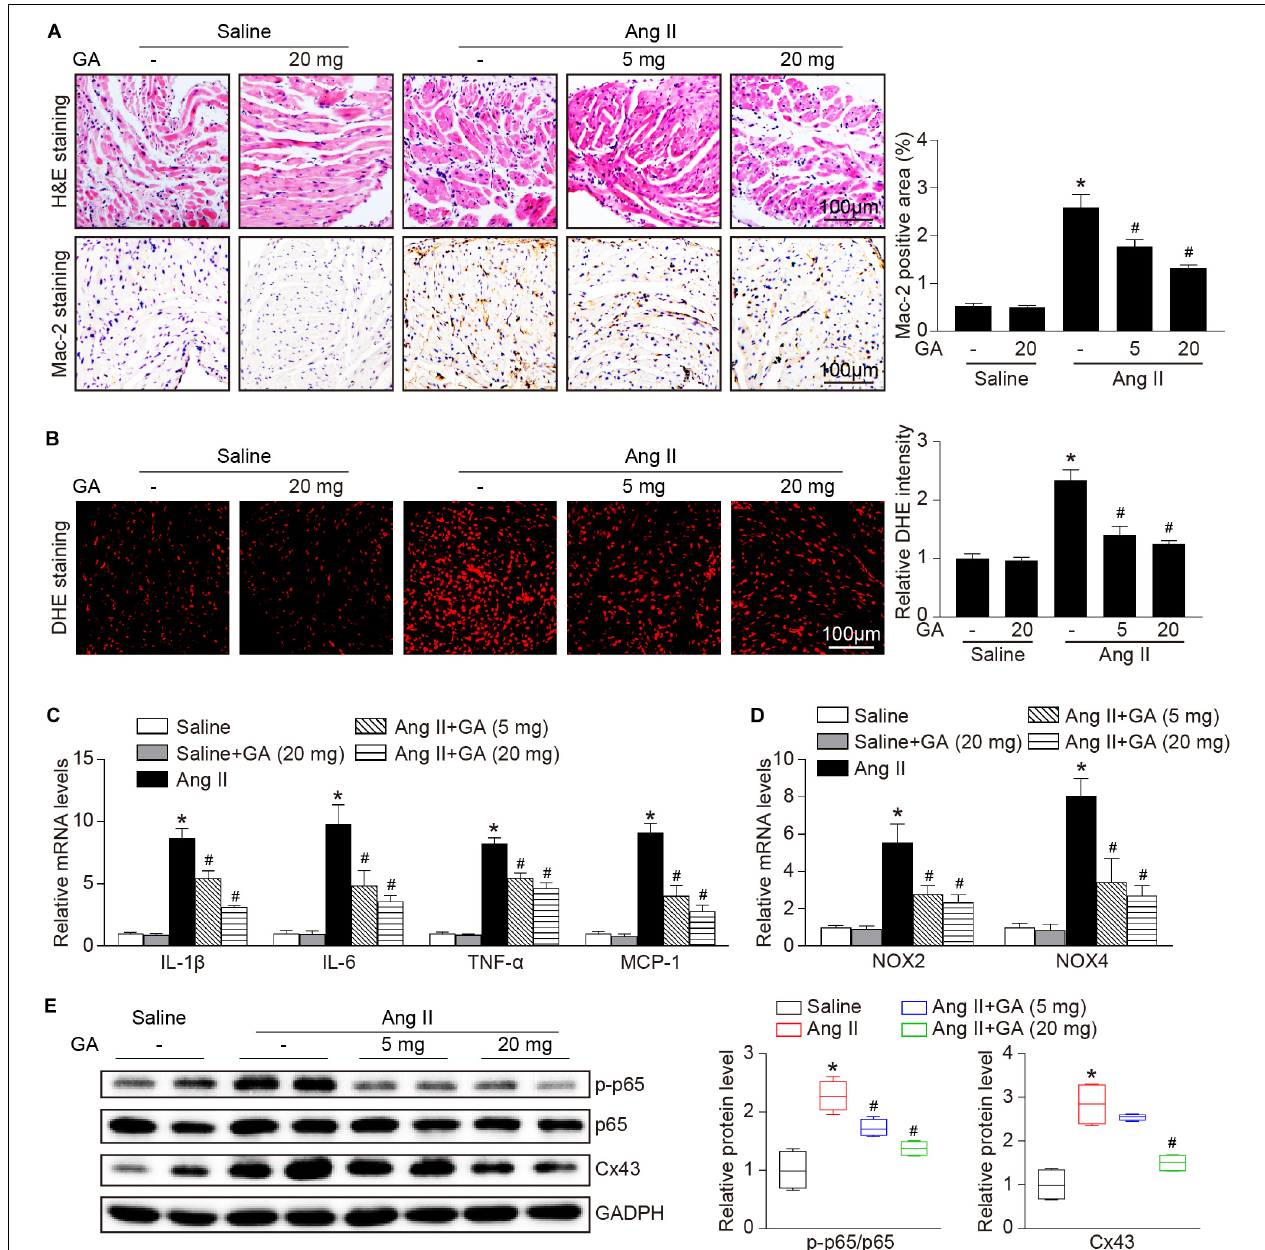
FIGURE 3 | GA reduces atrial inflammation and oxidative stress in mice after Ang II infusion. (A) Representative H&E staining (top) and Mac-2 immunohistochemistry (bottom) in the atria. Quantification of Mac-2–positive cells (right, n = 6). Scale bar: 100 µ m. (B) DHE staining of atrial superoxide production (left), and quantification of DHE intensity (right, n = 6). Scale bar: 100 µ m. (C) qPCR analyses of the mRNA expression levels of IL-1 β , IL-6, TNF- α , and MCP-1 ( n = 6). (D) qPCR analyses of the mRNA expression of NOX2 and NOX4. (E) Immunoblotting analysis of the protein expression levels of p-p65, p65, and Cx43 in the atria (left), and quantification of each protein band (right, n = 4). GAPDH as an internal control. * P < 0.05 versus saline, # P < 0.05 versus Ang